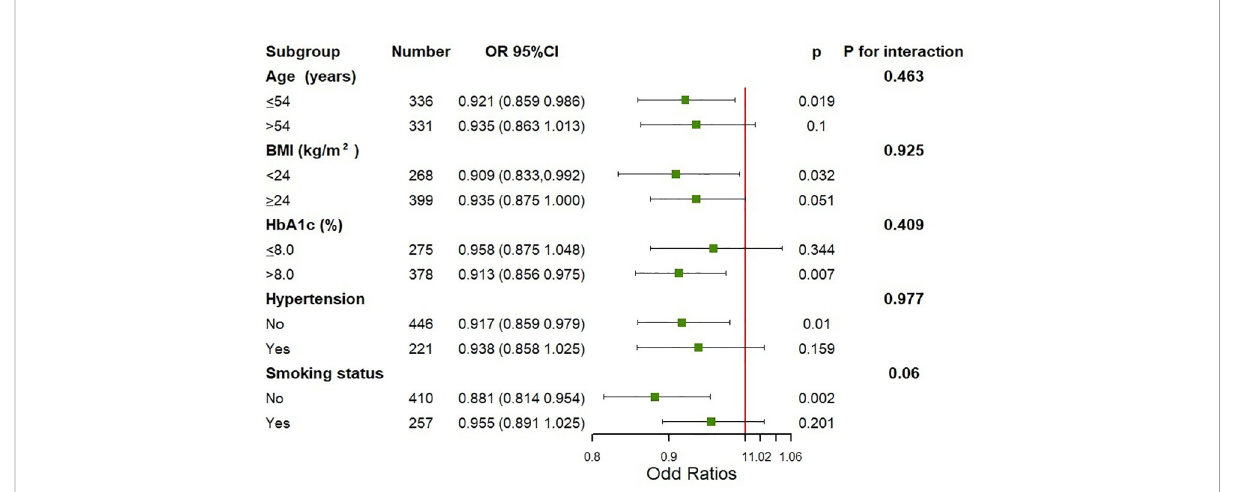
FIGURE 2 Subgroup analysis on the association between N-MID and the prevalence of severe insulin resistance assessed by the TyG index. Adjusted for age, BMI, diabetes duration, HbA1c, TC, hypertension, smoking status, the use of hypoglycemic agents and the use of lipid-lowering agents, if not be strati fi ed.